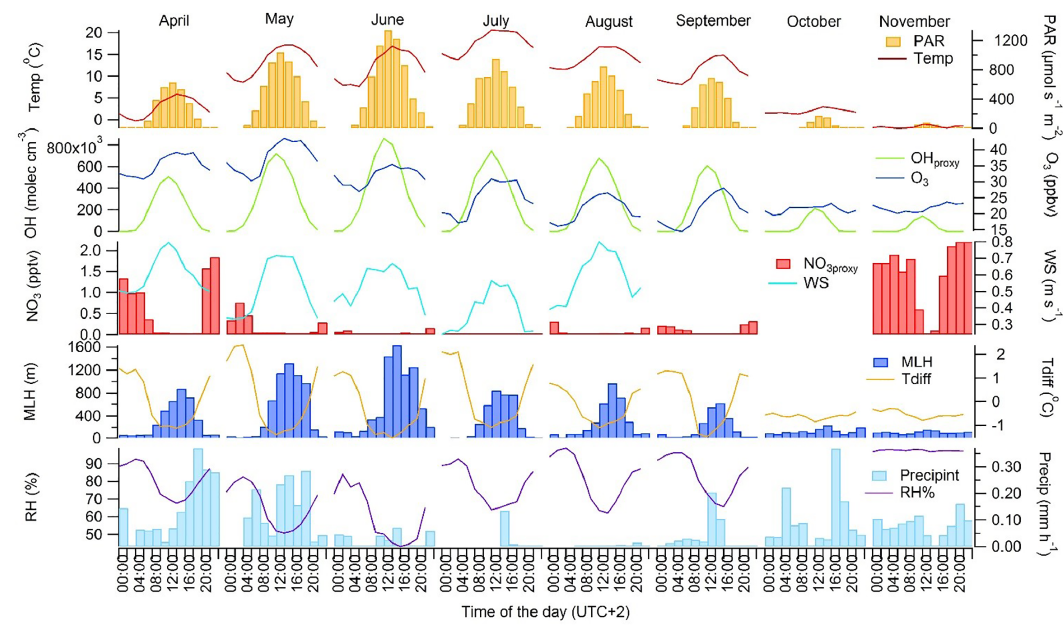
Figure 3. Monthly mean diurnal variation in meteorological parameters and concentrations of main oxidants (OH radical, O 3 and NO 3 radical) in 2016 during the GC-MS3 measurement periods. PAR: photosynthetically active radiation; WS: wind speed at the height of 8.4m; MLH: mixing layer height; Tdiff: temperature difference between heights of 125 and 4.2m; RH: relative humidity; precipint: intensity of precipitation. WS data for September–November and NO 3 radical and RH data for October are